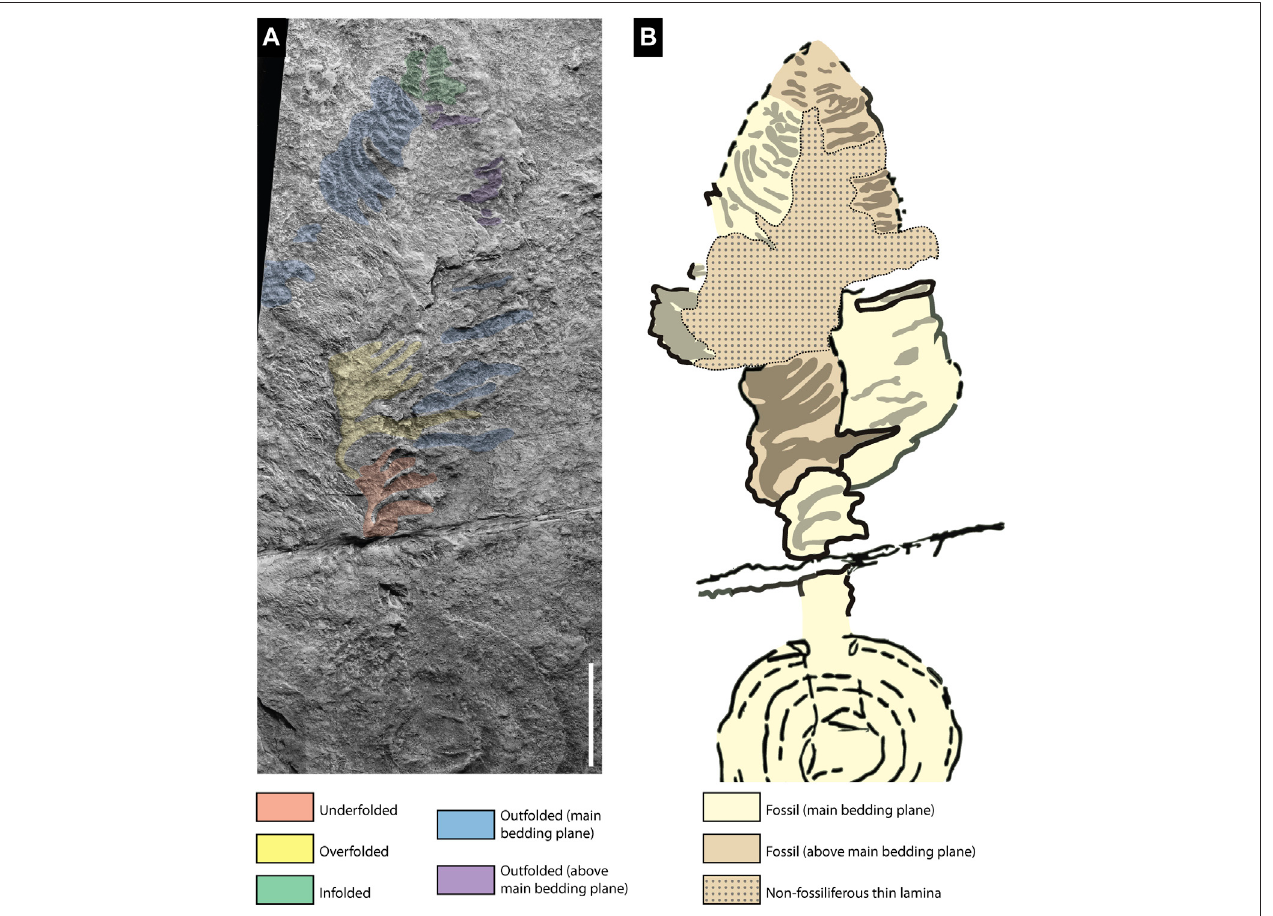
FIGURE 3 | Preservation of the holotype of C. concentricus (LEIUG 2383) from Charnwood Forest, UK. (A) Differential branch folding; underfolded (orange), overfolded (yellow), outfolded (blue and purple) and infolded (green). (B) Interpretive drawing of the fossil showing features preserved in different bedding planes; main bedding plane (yellow), above bedding plane (brown), and non-fossiliferous sediment (dotted brown pattern). Scale bar 3 cm. Not retrodeformed.